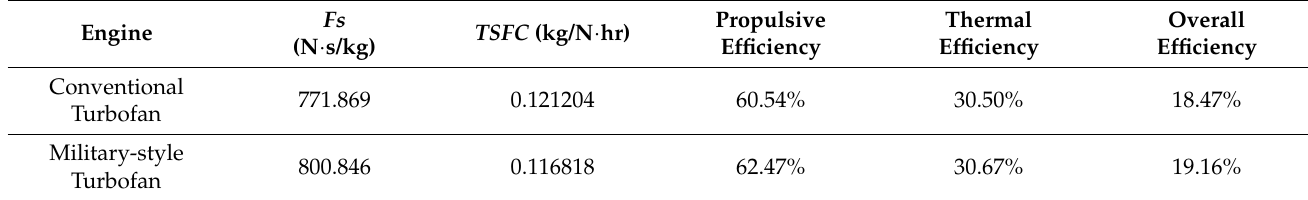
Table 2. Performance with Bypass Ratio Fixed at 0.1.